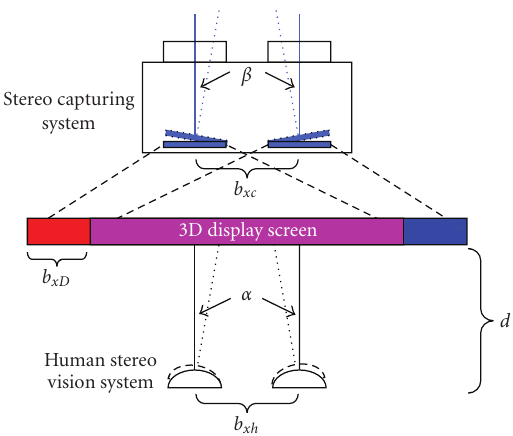
Figure 1: Process of capturing, display, and watching stereo